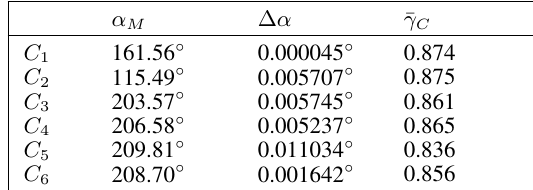
Table 1. Acquisition properties of the POLYGONE measurement campaign.